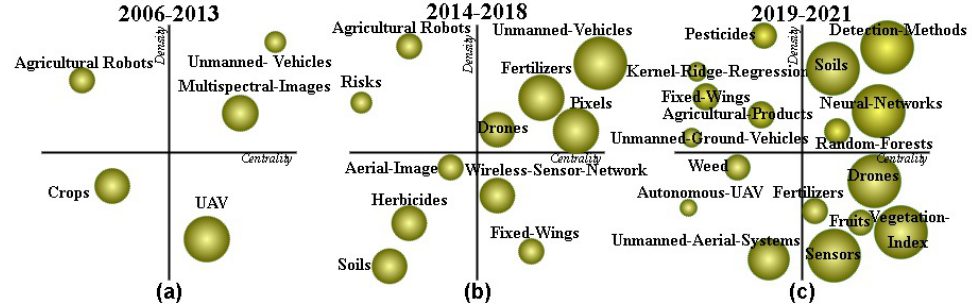
Figure 3. Strategic diagram shows keywords of ( a ) 2006–2013, ( b ) 2013–2018 and ( c ) 2018–2021. The horizontal axis (centrality) depicts the importance of each subject and the number of links it has with other themes, while the vertical axis (density) depicts the number of connections between each